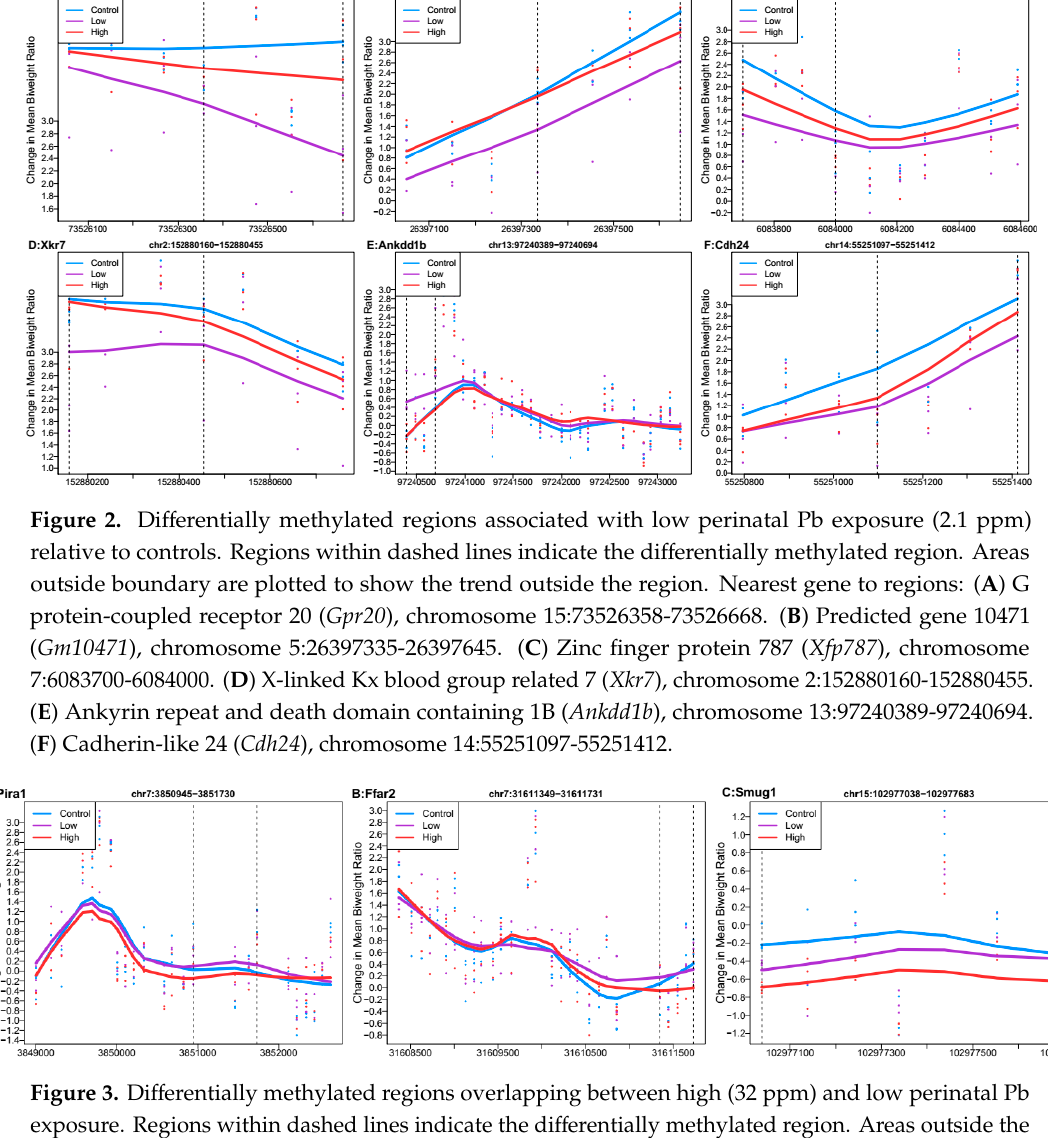
Genes 2019 , 10 , 274 6 of 15 Figure 1. Differentially methylated regions associated with high perinatal Pb exposure (32 ppm) relative to controls. Top hits reaching Stouffer <0.5. Regions within dashed lines indicate the differentially methylated region. The area outside the boundary are plotted to show trends outside the region. Nearest gene to regions: ( A ) Predicted pseudogene 7609 ( Gm7609 ), chromosome 1:85268190-85268860. ( B ) RIKEN cDNA D130017N08 gene ( D130017N08Rik ), chromosome 5:144518792-144519402. ( C ) Artemin ( Artn ), chromosome 4:117599180-117599790. ( D ) Zinc finger protein 974 ( Zfp974 ), chromosome 7:28716109-28717334. ( E ) Predicted gene 2012 ( Gm2012 ), chromosome X:25736758-25738103. ( F ) Complement component 5a receptor 1 ( C5ar1 ), chromosome 7:16846702-16847382. When comparing the low Pb dose group relative to controls, no regions had Stouffer p -value < 0.988. Several regions had Stouffer values of approximately 0.9881, and the six regions with the largest mean ratio difference are shown in Figure 2. Of these regions, the one most differentially methylated was linked to G protein-coupled receptor 20 ( Gpr20 ). Five regions linked to Gpr20 , predicted gene 10471